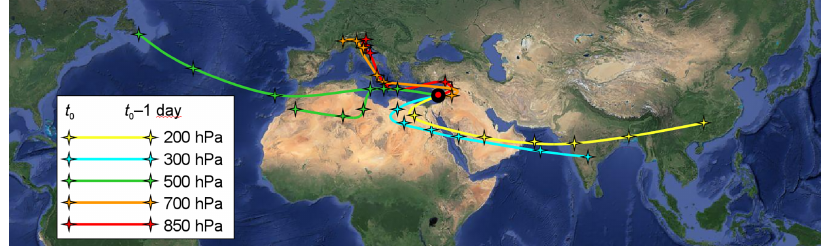
Figure 26. The 6-day back-trajectory climatology from the point at 33 ◦ N and 35 ◦ E located off Israel in the eastern Mediterranean Basin (red filled circle) derived for July–August over 2001–2010 every 12h. The position of the gravity center of each distribution (i.e., the maximum in the probability density function) at each level is represented every 24h by a star (adapted from Ricaud et al., 2014).